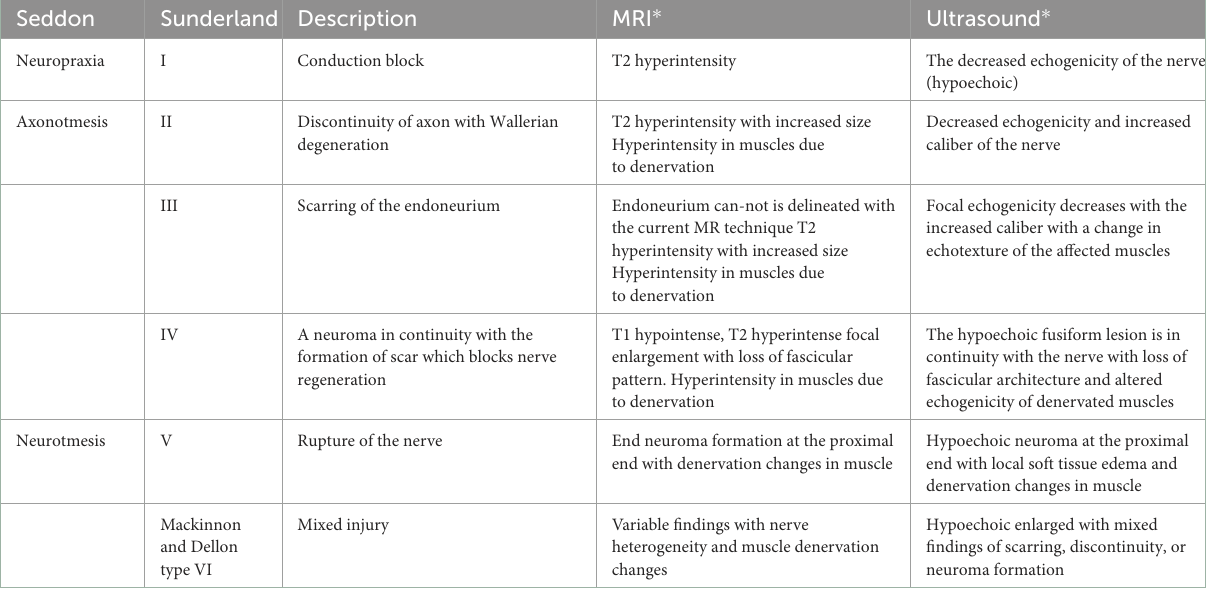
TABLE 1 Nerve injury classification following Seddon and Sunderland theories.